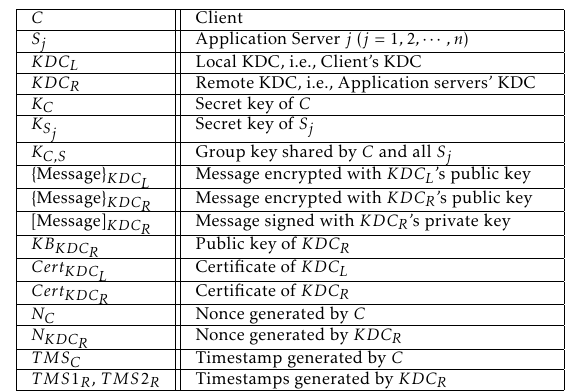
Table 4. The Notation Used In The Case of A Single Remote Realm